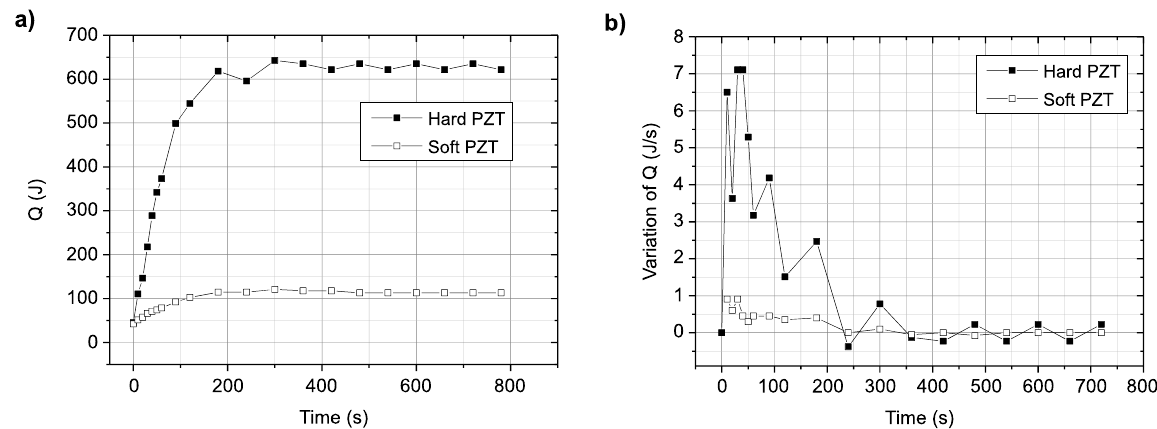
Figure 6. Variation in heat loss as a function of time for PZT transducer: ( a ) change in the total heat loss and ( b ) change in the heat loss per unit time.